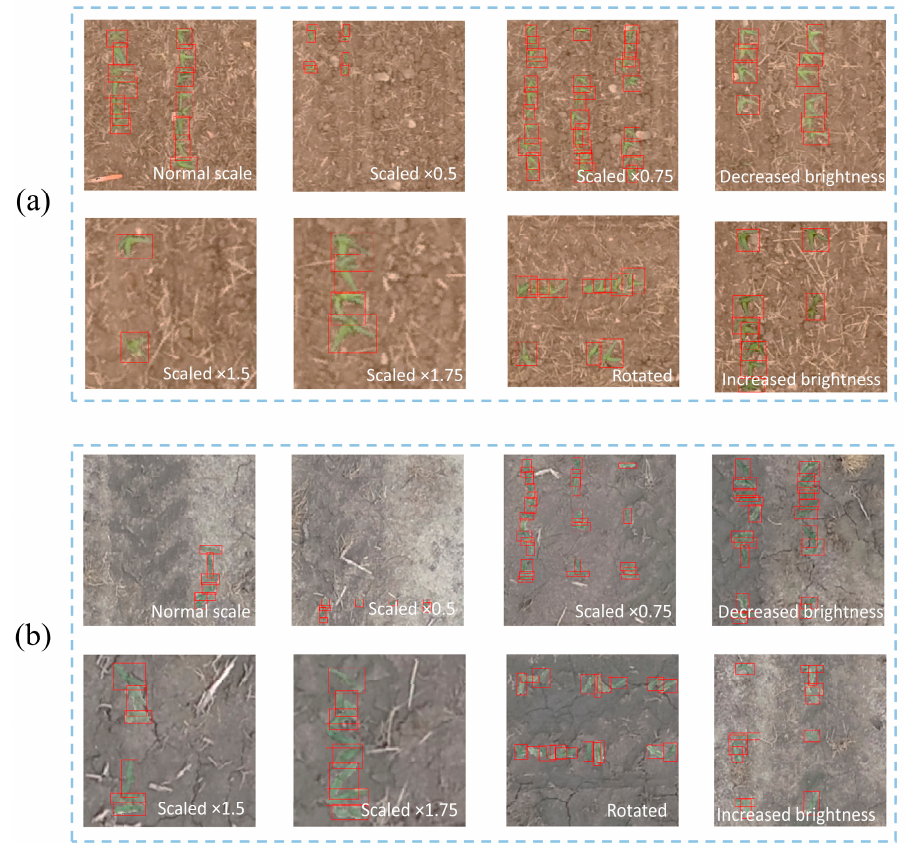
Figure 8. Some instances of the generated images, based on the proposed method for the first ( a ) and the second ( b ) datasets.